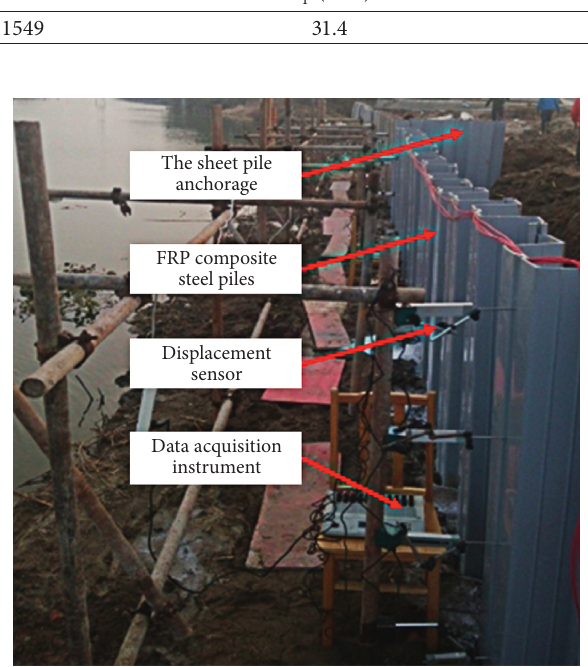
Figure 3: Lateral bearing capacity of FRP composite sheet piles for field testing.